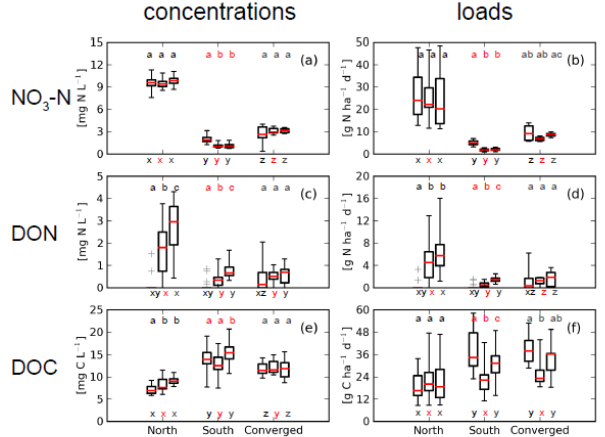
Fig. 4. Boxplots of measured NO − -N ( a and b ), DON ( c and d ) and 3 DOC ( e and f ) concentrations and loads for the northern, southern and converged part. Each group of three boxes corresponds to val- ues measured in April, August and September, respectively. Mark- ers indicate quartiles. In cases where most of the measured values were under detection limits, remaining single values are shown with crosses. Letters a, b and c above markers indicate significant differ- ences between the mean values of April, August and September, whereas letters x, y and z denote significant differences between the three stream branches referring to one sampling period. Colours indicate the compared groups of either date or stream